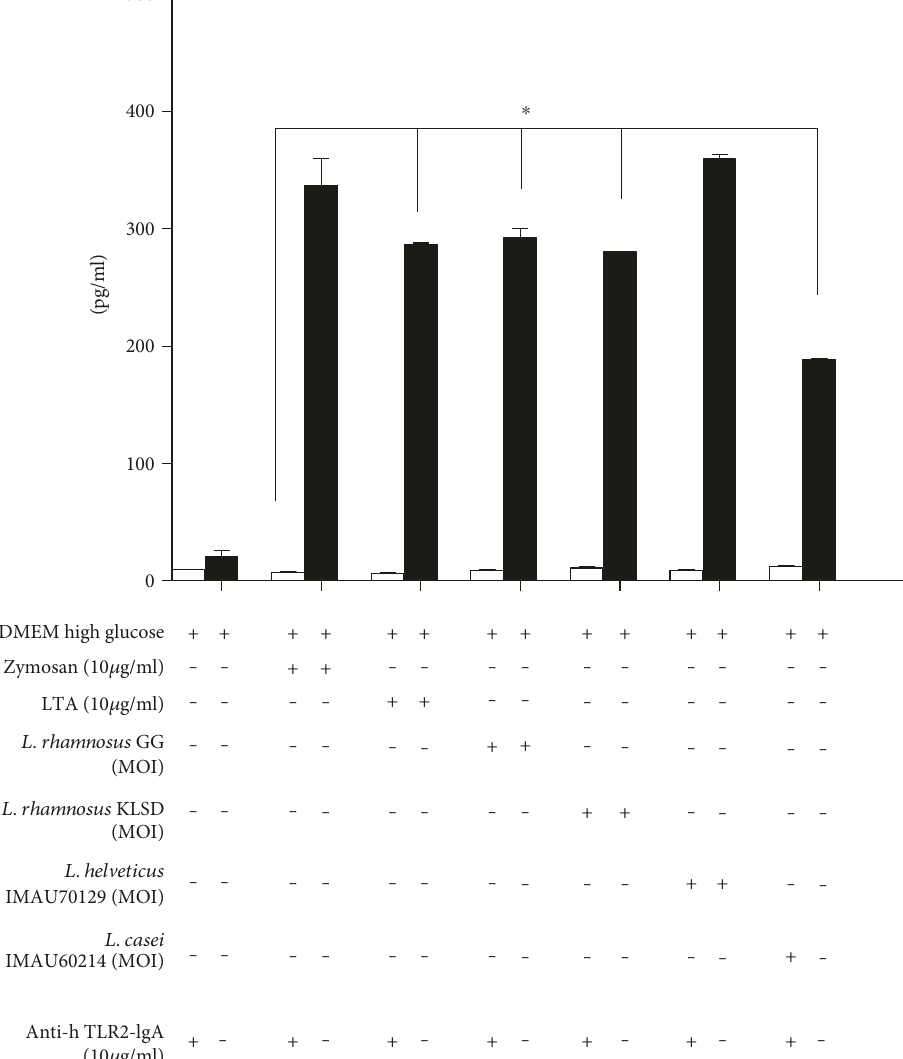
Figure 6: Transfection assay of HEK293-hTLR2 cells showing IL-8 was secreted in response to strains of lactobacillus. The recognition of lactobacillus strains was evaluated using a model in which HEK293-hTLR2 cells were transfected, and then blocking assays were performed using anti-hTLR2-IgA antibodies at a concentration of 10 μ g/ml. p < 0 05 ( ∗